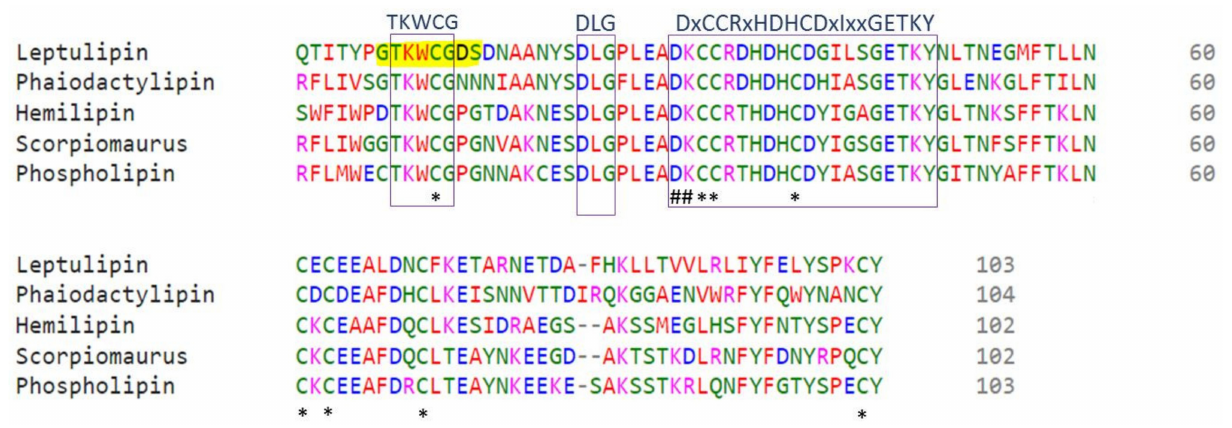
Figure 5. Multiple sequence alignment of leptulipin with other scorpion PLA2 sequences (phos- pholipin, phaiodactylipin, Scorpio maurus PLA2, and hemilipin) by Clustal Omega. Boxes show the evolutionary signature in the selected similar sequences as TKWCG, DLG, and DxCCRxHD- HCDxIxxGETKY. Conserved cysteine and the main catalytic residues are represented by * and #, respectively. The yellow box shows the calcium-binding loop.